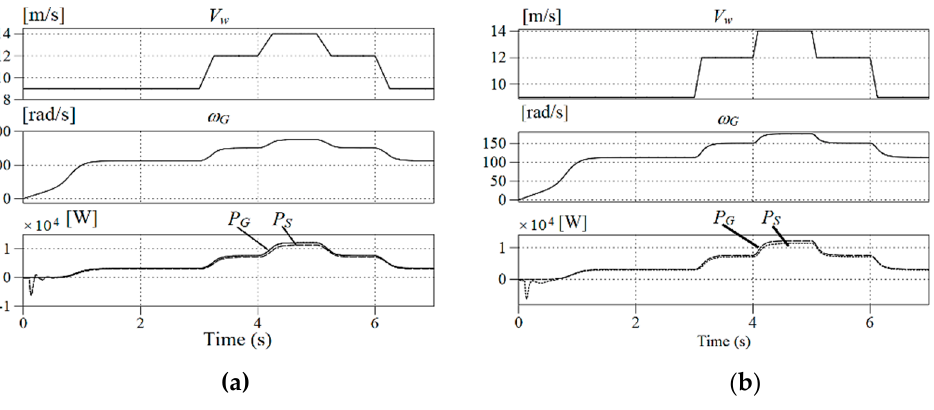
Figure 12. Waveforms of wind speed V w ( a ) 12, 8, − 8, − 12 [m/s 2 ]; ( b ) 24, 24, − 24 − 24 [m/s 2 ] generator angular speed ω G and power P G , and grid power P S , for β = 10°.